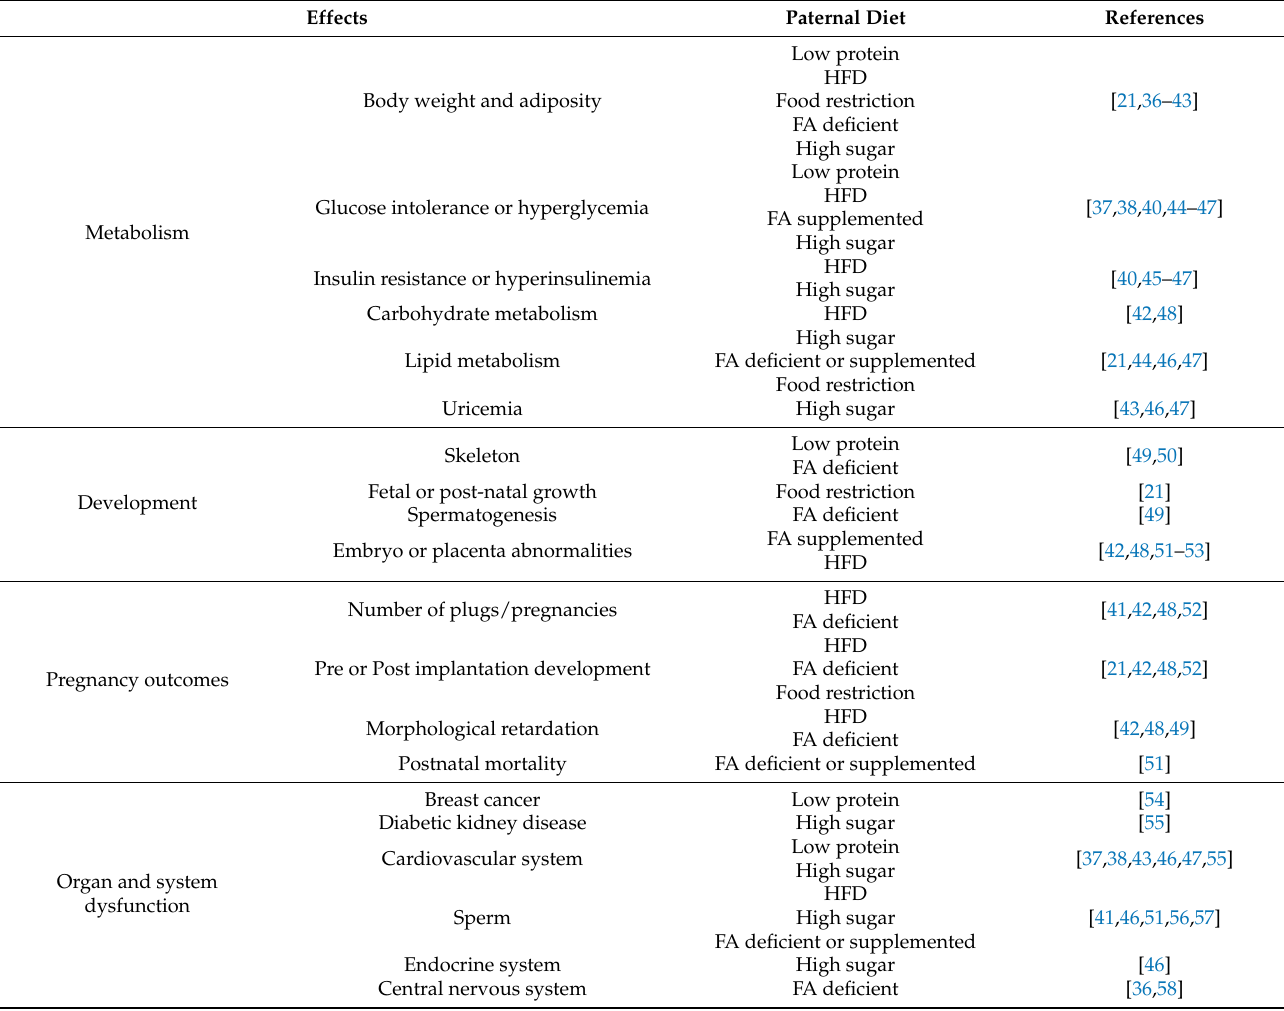
Table 1. Paternal nutrition status